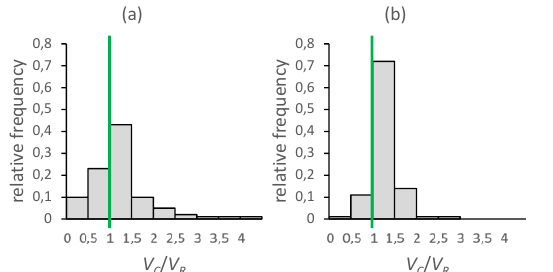
Figure 11. Volume ratio V c /V R of crowdsourced to reference MBBs: (a) before outlier detection and integration, (b) after outlier detection and